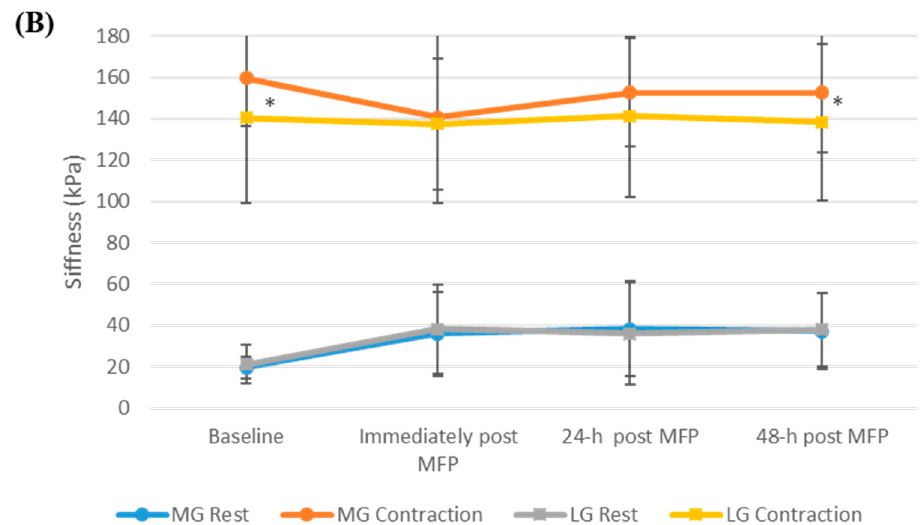
Figure 3. Differences between the stiffness of the medial and lateral gastrocnemius muscles, at rest and in contraction states, across all the measurement time points as measured using ( A ) MyotonPRO and ( B ) shear wave elastography. * Significant differences between the muscles at 0.05 level.